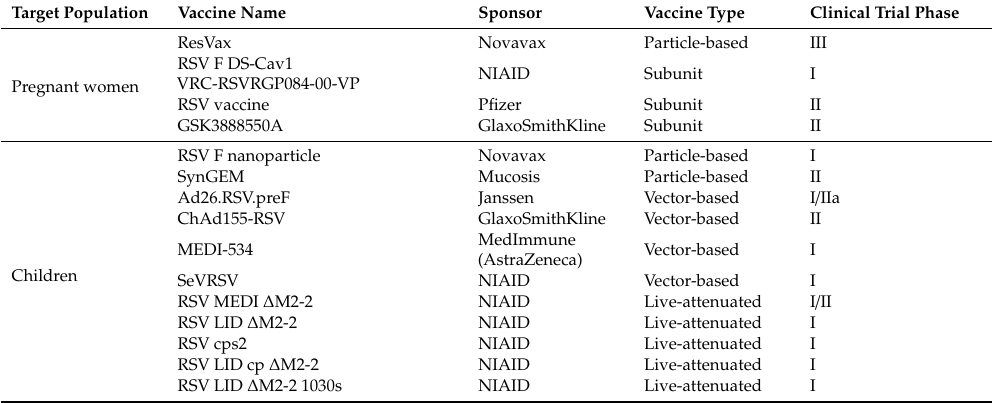
Table 1. Summary of the RSV vaccines and monoclonal antibodies in clinical development by target population. Only the most advanced trial for a specific target group is reported. RSV: respiratory syncytial virus; NIAID: National Institute of Allergy and Infectious Diseases; mAb: monoclonal